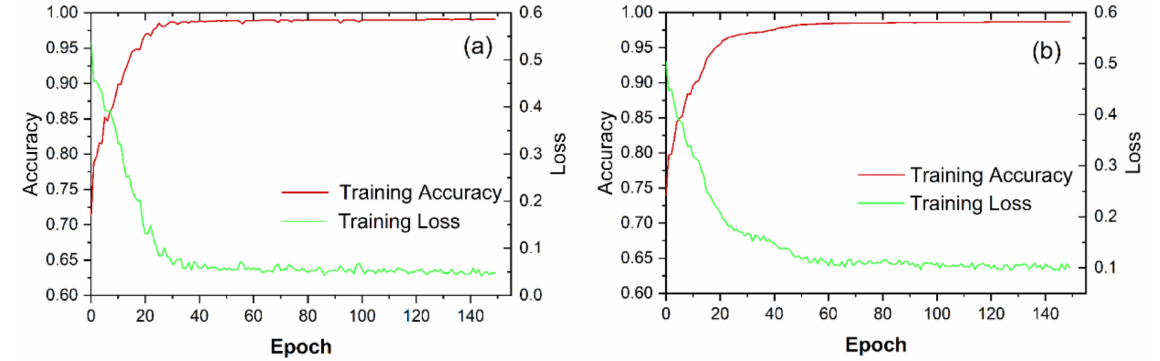
Figure 7. Training curves of the CNN-based model in ( a ) Zhangzha Town and ( b ) Lantau